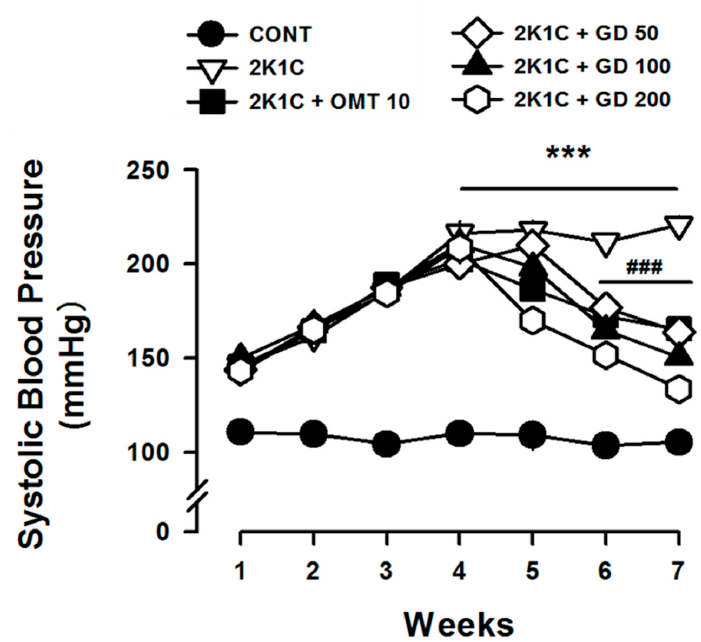
Figure 2. Effect of Gynura divaricata ( L .) DC on systolic blood pressure (mmHg). The GD treatments at different concentrations (50, 100, 200 mg/kg/day) decreased systolic blood pressure (SBP) in 2K1C hypertensive rats. The values are expressed as the mean ± standard error ( n = 10 per group). *** p < 0.001, vs. CONT and ### p < 0.001, vs. 2K1C. 2K1C, two-kidney